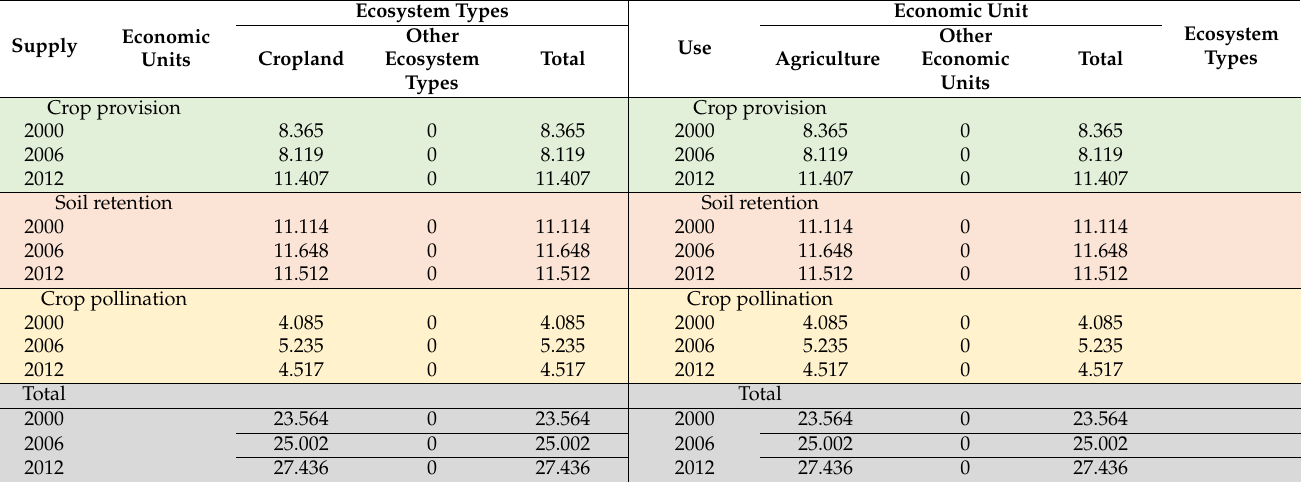
Table 2. Supply and use tables of three ecosystem services with no double counting (million EUR, year